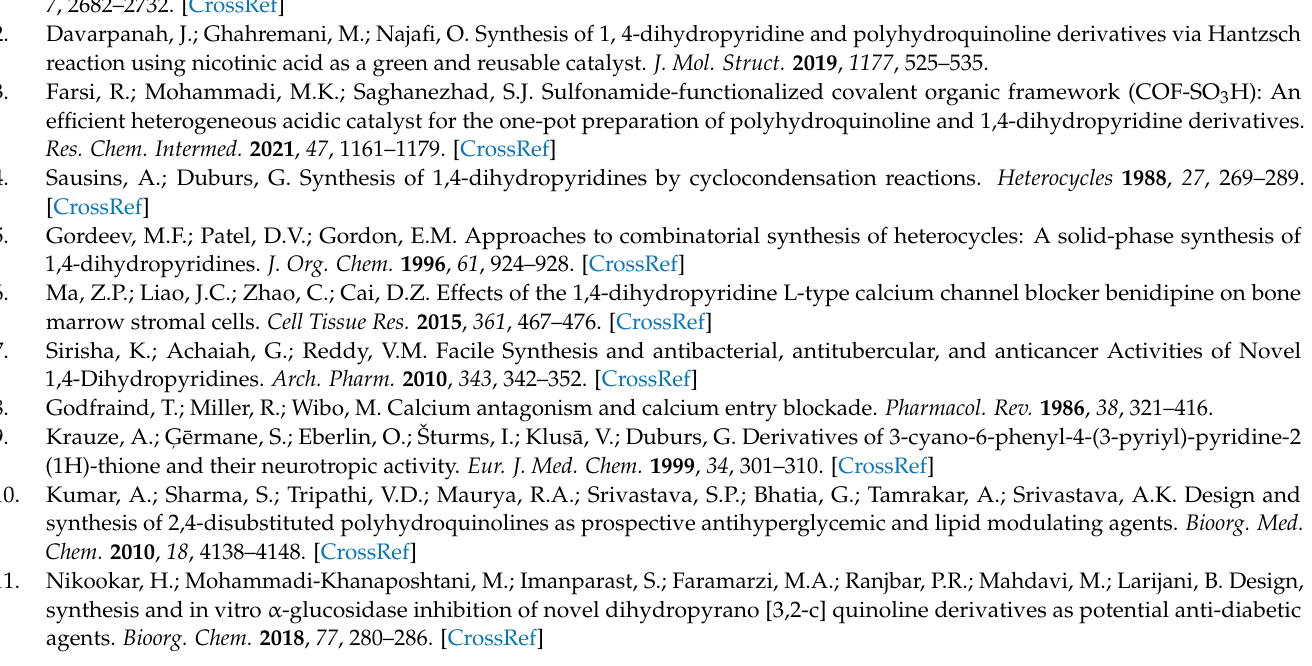
spectra of compound 16 ; Figure S19: Mass, 1 H- and 13 C-NMR spectra of compound 17 ; Figure S20: Mass, 1 H- and 13 C-NMR spectra of compound 18 ; Figure S21: Mass, 1 H- and 13 C-NMR spectra of compound 19 ; Figure S22: Mass, 1 H-NMR and 13 C-NMR spectra of compound 20 ; Figure S23: Mass and 1 H-NMR spectra of compound 21 ; Figure S24: Mass, 1 H- and 13 C-NMR spectra of compound 22 ; Figure S25: Mass, 1 H- and 13 C-NMR spectra of compound 23 ; Figure S26: Mass, 1 H- and 13 C-NMR spectra of compound 24 ; Figure S27: Mass, 1 H- and 13 C-NMR spectra of compound 25 ; Figure S28: Mass, 1 H- and 13 C-NMR spectra of compound 26 ; Figure S29. HR-ESI-MS, 1 H- and 13 C-NMR spectra of compounds 27